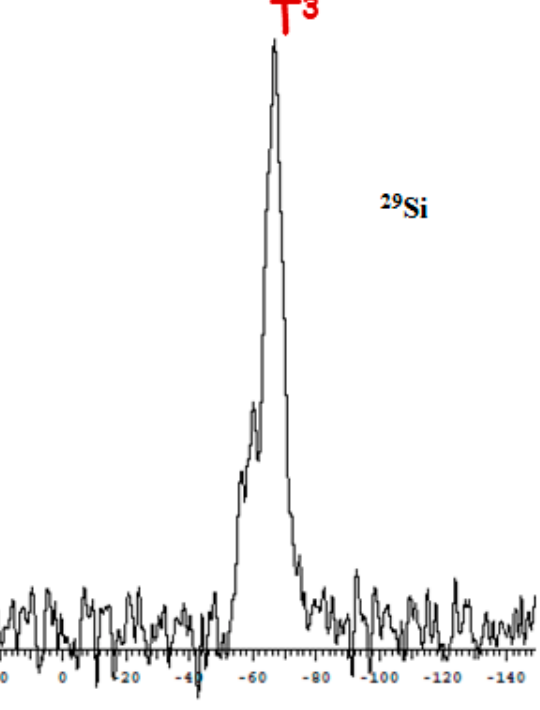
Figure 1. 29 Si CPMAS solid-state NMR spectrum of the hybrid material M4 110 .